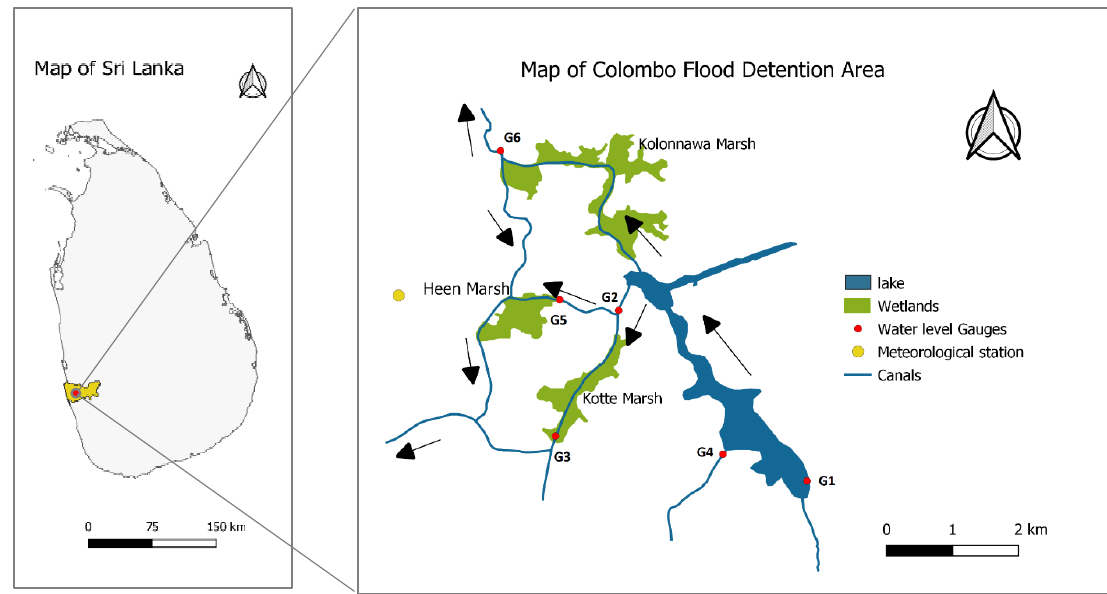
Figure 3. Selected catchment for the study: Colombo flood detention basin. Four water level monitoring stations are located within the basin, Kimbulawala Bridge, Kotte North Canal, Kotte Canal, and Parliament Lake. The data set of each wetland contains daily water levels and the readings of other independent meteorological variables. Wetland water level data were obtained from Sri Lanka Land Development Corporation, while meteorological data were obtained from the Department of Meteorology, Sri Lanka. The number of data points recorded for each wetland selected for the study differs. Therefore, considering the number of data points, the train-test data split was decided as presented in Table 3. Table 3. Train-Test Data Split . Wetland